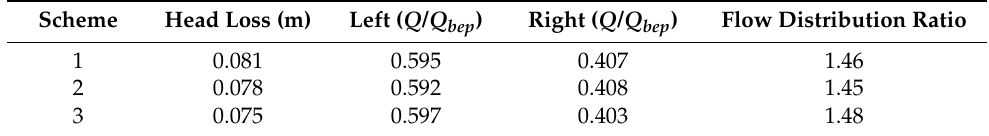
Table 2. Flow distribution on both sides of division pier in three schemes.